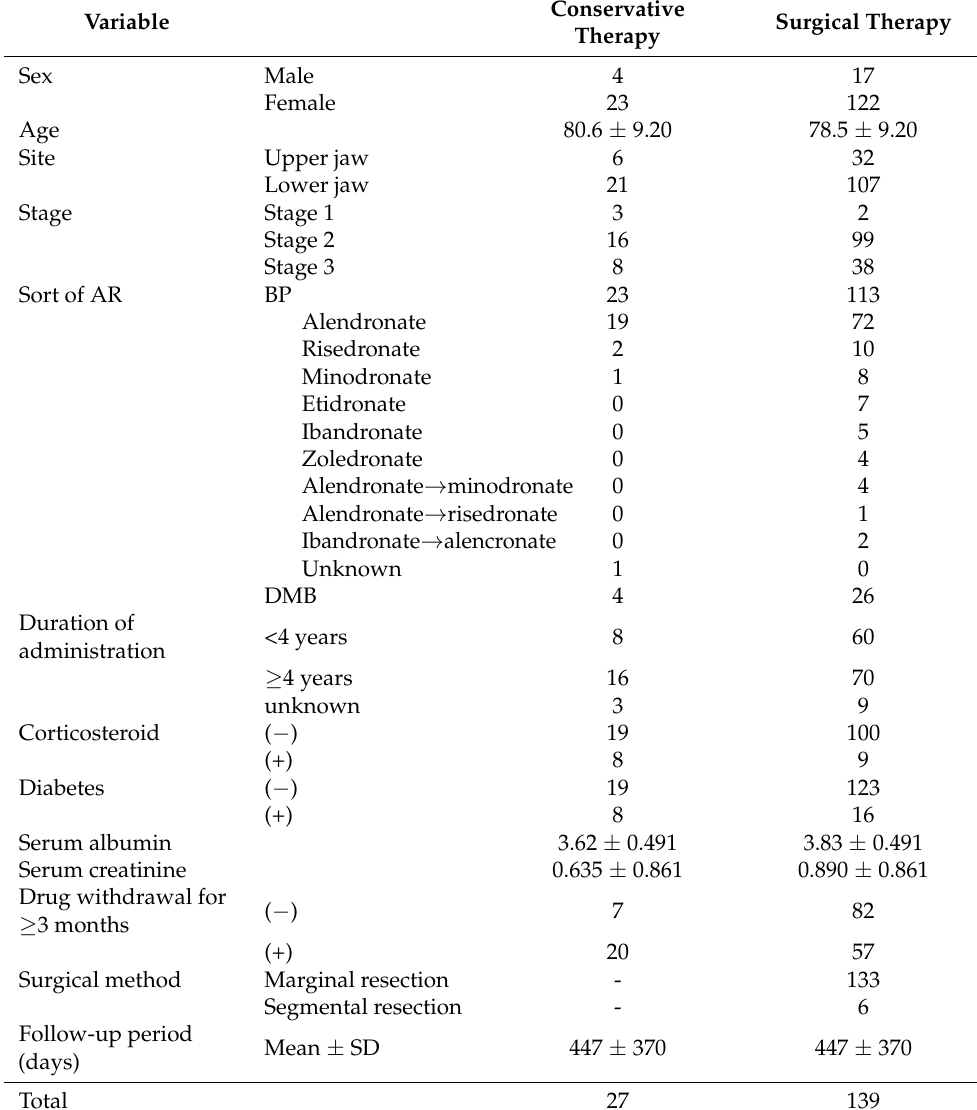
Table 1. Patient